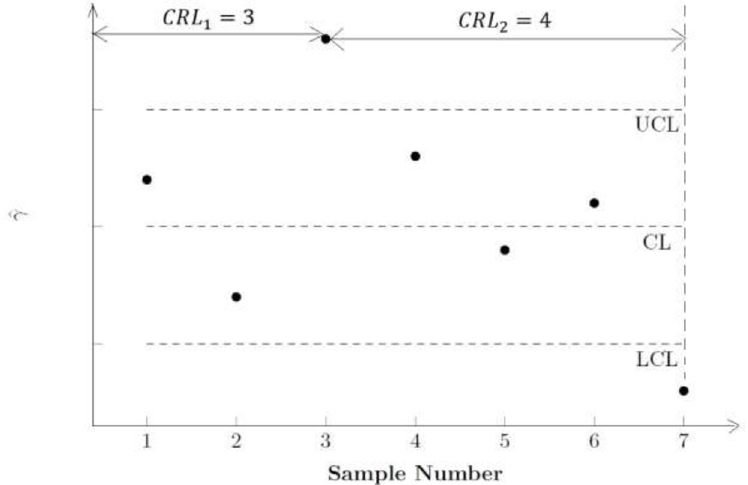
Fig 1. The CRL sub–chart of the Non–side–sensitive Synthetic– γ (NSS) chart.